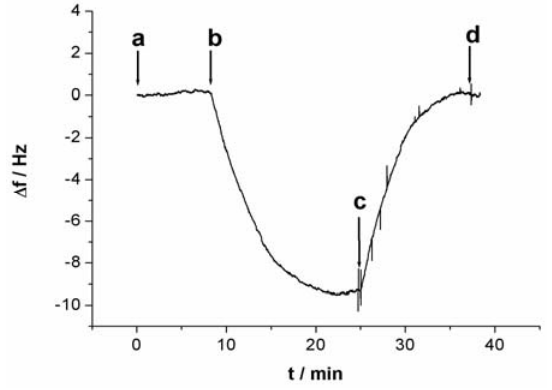
Figure 2. The response of QCM-based sensor to Hg 2+ . (a,b) section: 1 µM linking probe 2 solution was injected at a flow rate of 20 µL·min − 1 for 600 s; (b,c) section: 5 nM Hg 2+ solution was injected into the QCM cell; (c,d) section: 10 mM Tris-HCl buffer (pH 7.4) containing 50 mM cysteine was injected at a flow rate of 25 µL·min − 1 for 900 s.